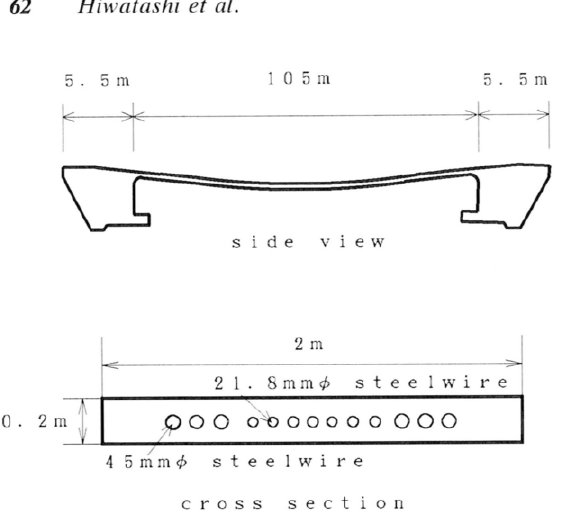
FIGURE 4 The Umenoki Bridge (a stress ribbon pe destrian bridge).